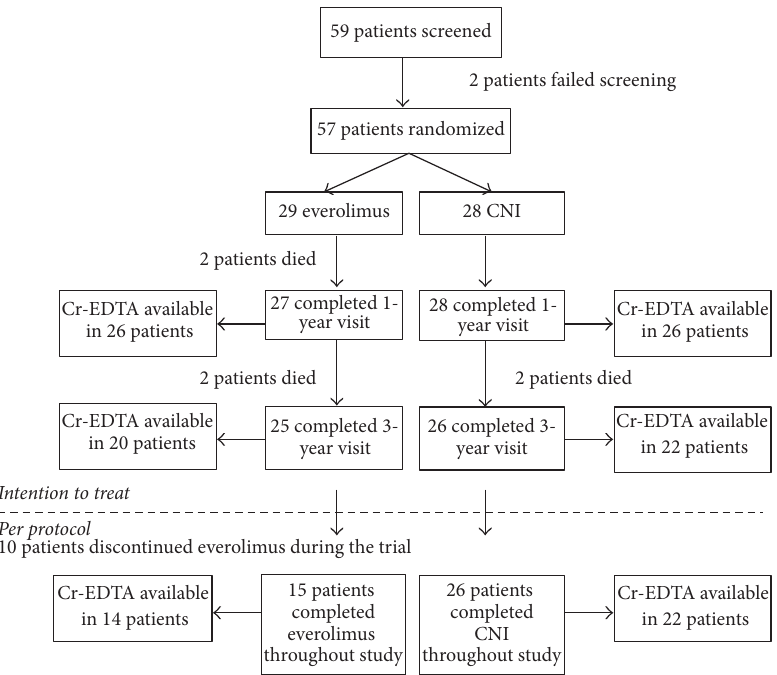
Figure 2: Study flowchart. CNI, calcineurin inhibitor; Cr-EDTA, measured glomerular filtration rate by Cr-EDTA clearance.